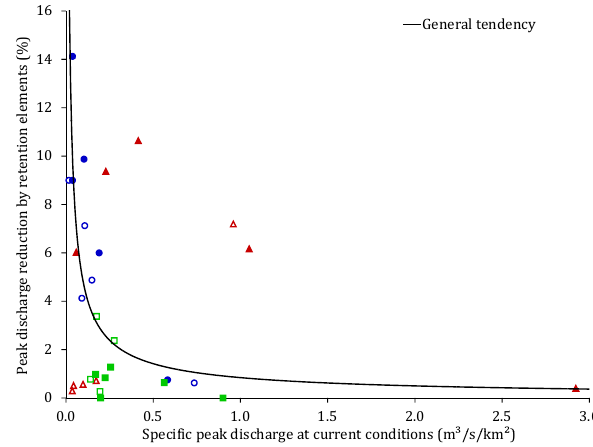
Fig. 9. Effect of the flood retention measures on peak discharge in the catchments outlets considering the same MAISC equal to 1.2mm and two initial soil moisture conditions: solid sym- bols means “wet” and empty symbols means “dry”. Catchments: (a) small-reservoirs at Poyo (red triangles), (b) micro-ponds at Up- per Iller (green squares) and (c) micro-ponds at Kamp (blue circles).